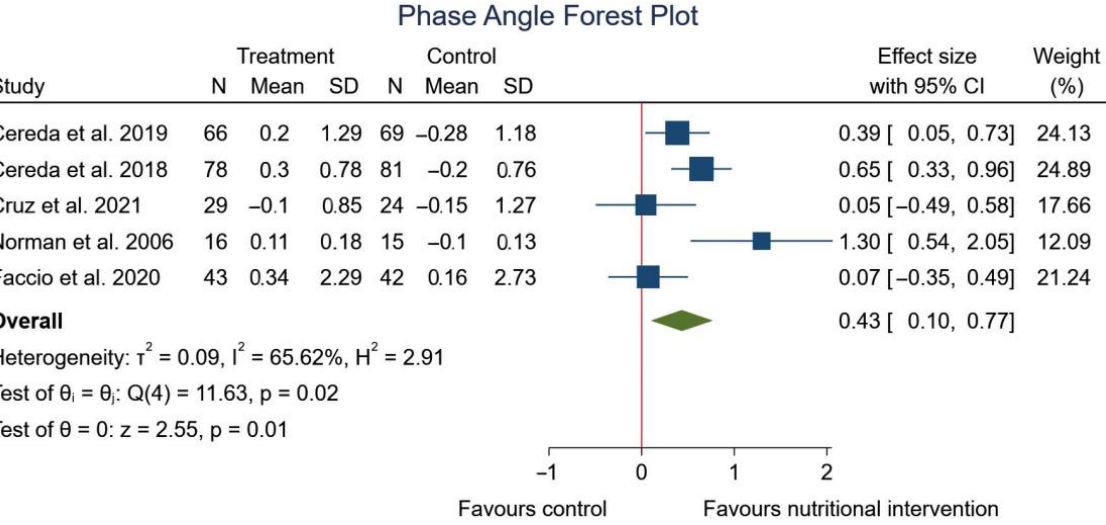
Figure 4. Forest plot detailing the mean difference and 95% confidence intervals (CI) for the effect of nutritional intervention on phase angle [39–42,52].